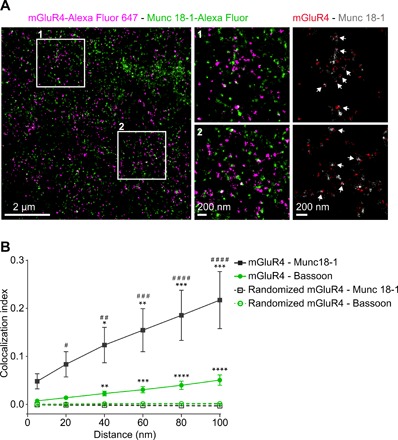
Arrangement of mGluR4 relative to bassoon and Munc-18-1 by distance-based colocalization analysis.(A) Representative two-color dSTORM imaging of mGluR4 (magenta) and Munc-18-1 (green). Left: Super-resolved dSTORM image revealing the organization of mGluR4 relative to Munc-18-1. Middle: Enlarged views corresponding to the regions delimited by the white boxes. Right: Images of same regions, where mGluR4 localizations are shown in red over Munc-18-1 localizations in gray (areas with no or low mGluR4 localization densities, corresponding to sites outside AZs, are not shown). White arrows, areas of colocalization between mGluR4 and Munc-18-1. (B) Distance-based colocalization analysis. Data shown are means ± SEM of seven or three dSTORM images from two independent preparations coimmunostained for mGluR4 and bassoon and one preparation coimmunostained for mGluR4 and Munc-18-1, respectively. Results were compared to those obtained with an equal number of random uniformly distributed mGluR4 localizations (dashed lines). Differences are statistically significant by two-way ANOVA followed by Holm-Sidak’s test. *P < 0.05, **P < 0.01, ***P < 0.001, and ****P < 0.0001 versus random localizations. #P < 0.05, ##P < 0.01, ###P < 0.001, and ####P < 0.0001 versus mGluR4-bassoon.